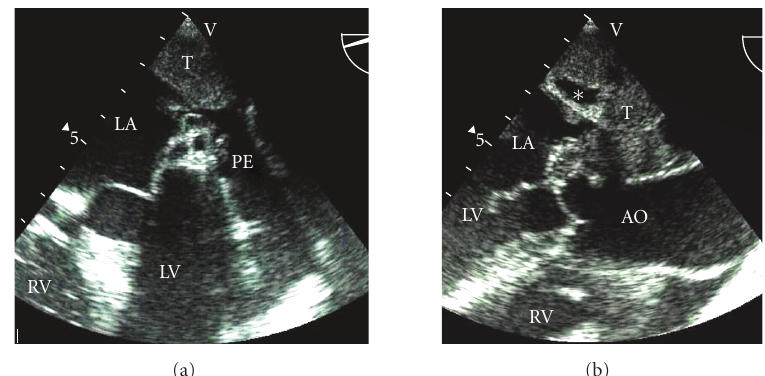
Figure 2: (a) Transesophageal echocardiogram of 4-chamber view showing tumor mass (T) compressing the left atrium (LA). A pericardial e ff usion (PE) is adjacent to the left ventricular (LV) free wall. RV = right ventricle. (b) Transesophageal echocardiogram of left ventricular (LV) outflow tract in long axis showing homogenous tumor (T) mass with lucent spaces ( ∗ ) compressing the left atrium (LA). AO = Ascending aorta. RV = right ventricle.